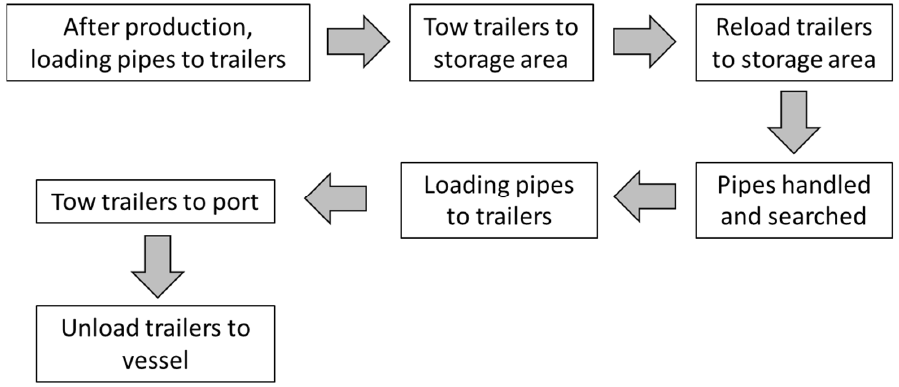
Figure 11. Current logistics process.